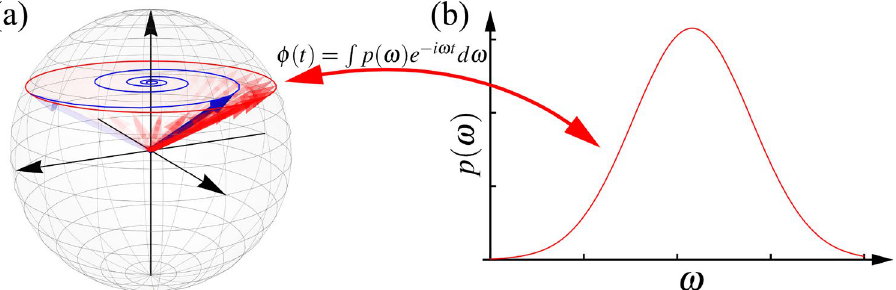
( p (cid:31) , H (cid:31) ) (cid:31) consists of a collection of Hermitian operators { } exp ( i H (cid:31) t / (cid:31) ) , denoted by red boxes, according to p (cid:31) . Finally, all U (cid:31) (cid:31) = − (cid:31) (cid:31)